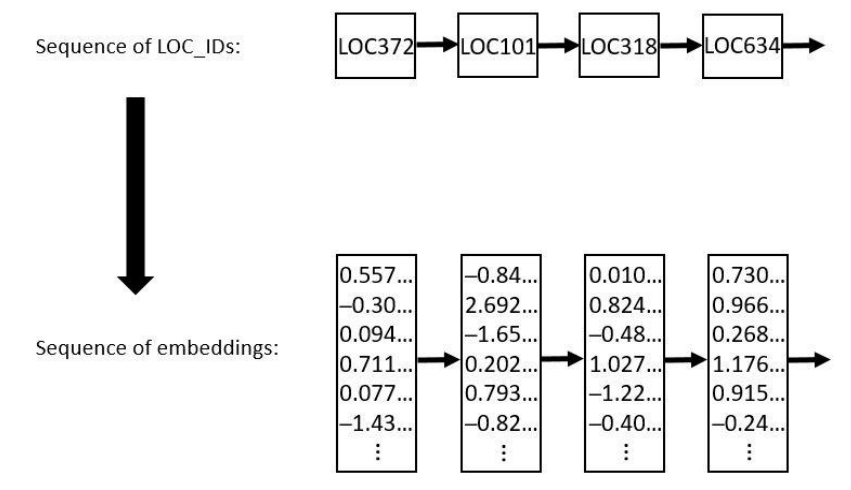
Figure 2. New trajectory representation as a sequence of location embeddings.